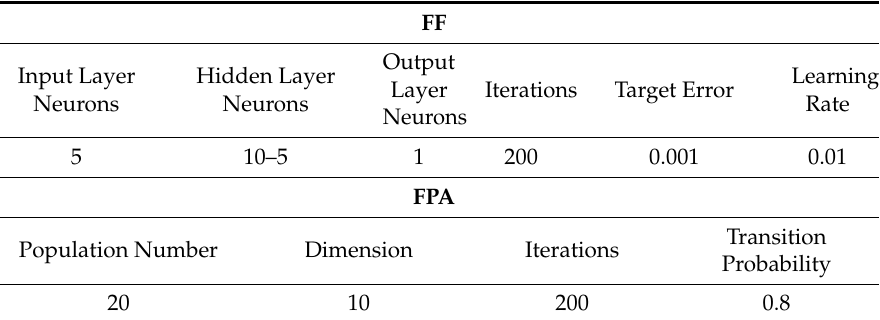
Table 6. Parameter Settings.